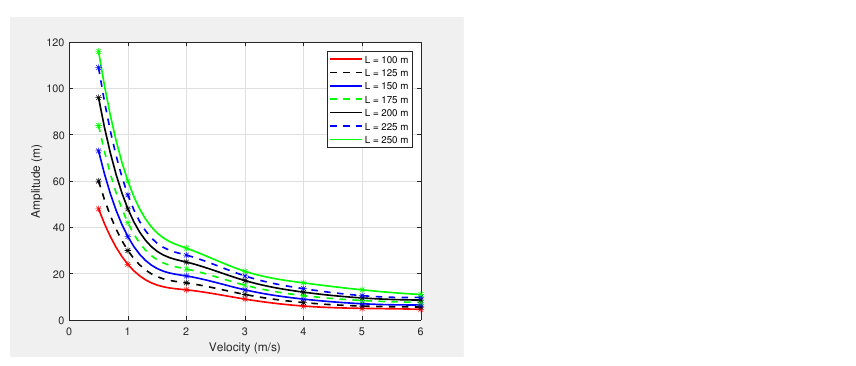
Figure 2. PX4-autopilot’s supported maximum amplitude vs. velocity for different